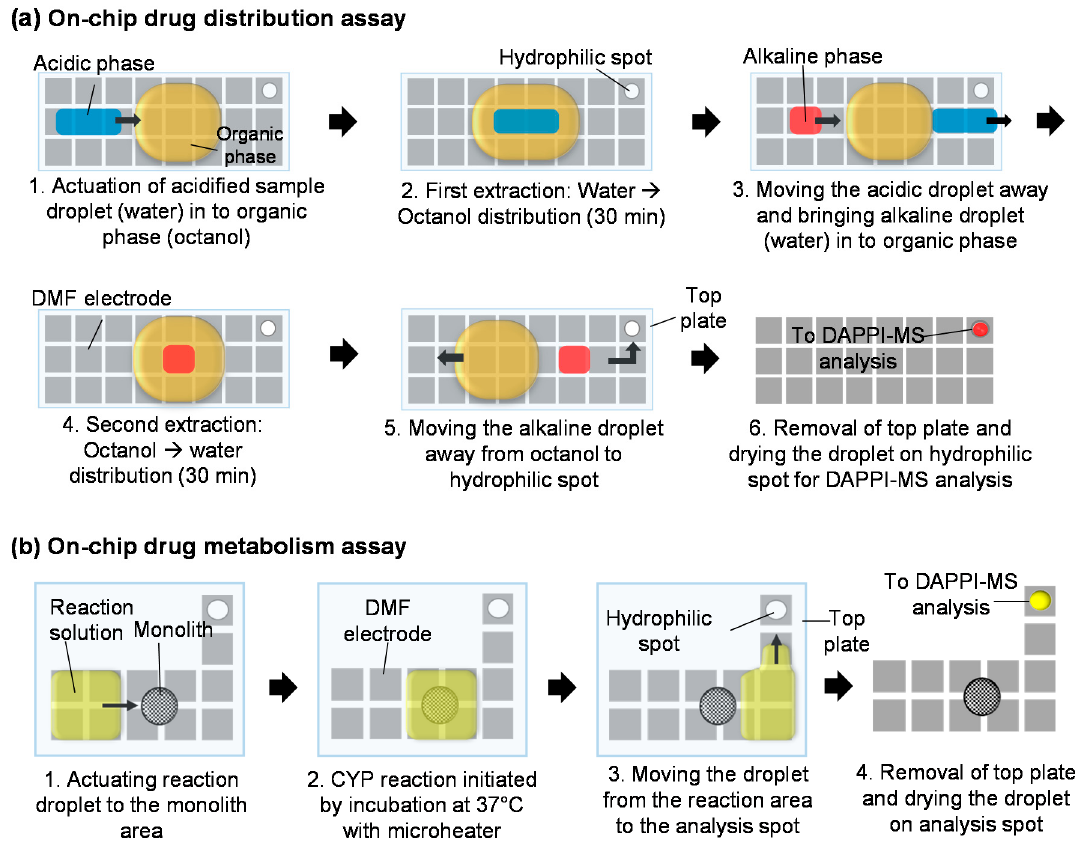
Figure 2. Schematic views of the main steps of ( a ) the on ‐ chip drug distribution assays and ( b ) the on ‐ chip drug metabolism